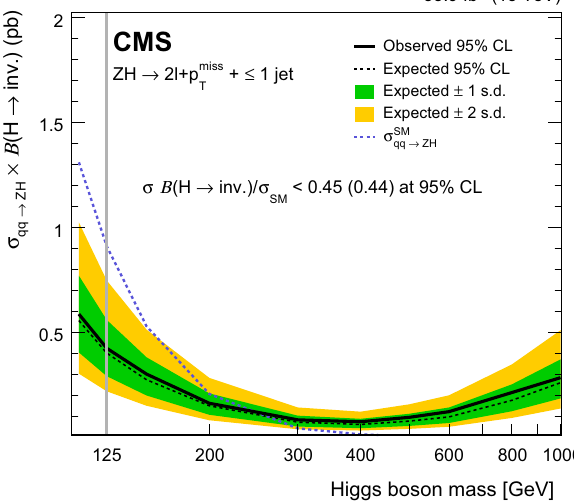
Fig. 9 Expected and observed 95% CL upper limits on the product of theproductioncrosssectionandthebranchingfraction, σ qq → ZH B ( H → inv. ) ,asafunctionoftheSM-likeHiggsbosonmass.Thelimitsconsider only quark-induced Higgs boson production. In addition, for the SM (125GeV) Higgs boson, the limit on branching fraction assuming SM productionrate(consideringalsogluonfusion)ispresented.Thevertical gray line indicates that the result at m H = 125GeV should not be read from the plot, as the gluon contribution is known for that point